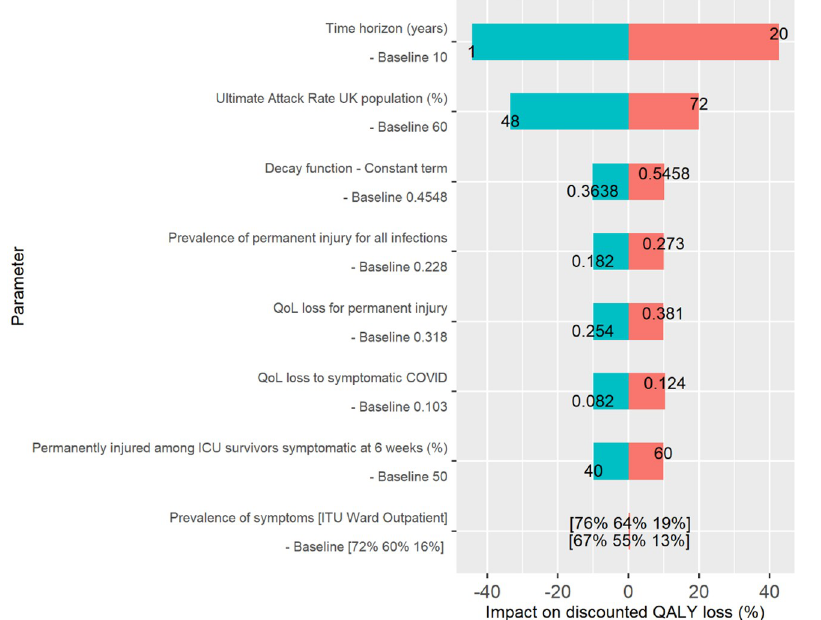
Fig 4. Results of sensitivity analysis on key